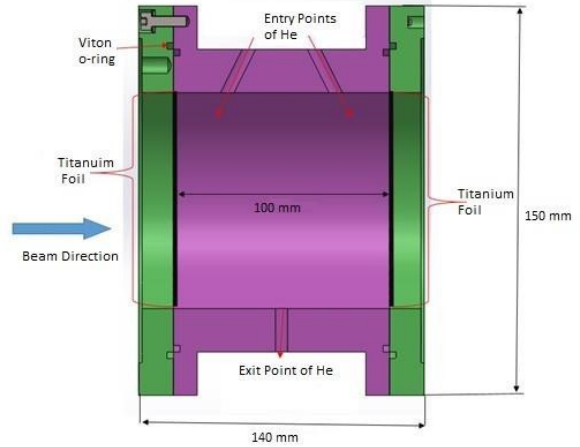
Fig. 15. Helium cooling chamber design of METU-DBL. The titanium foils were placed between the flanges shown in green and purple